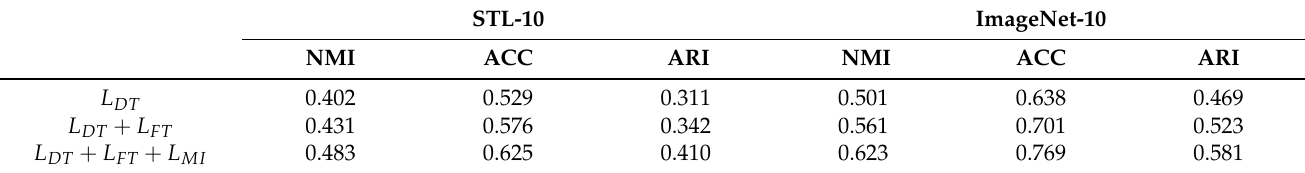
Table 6. The impact of each